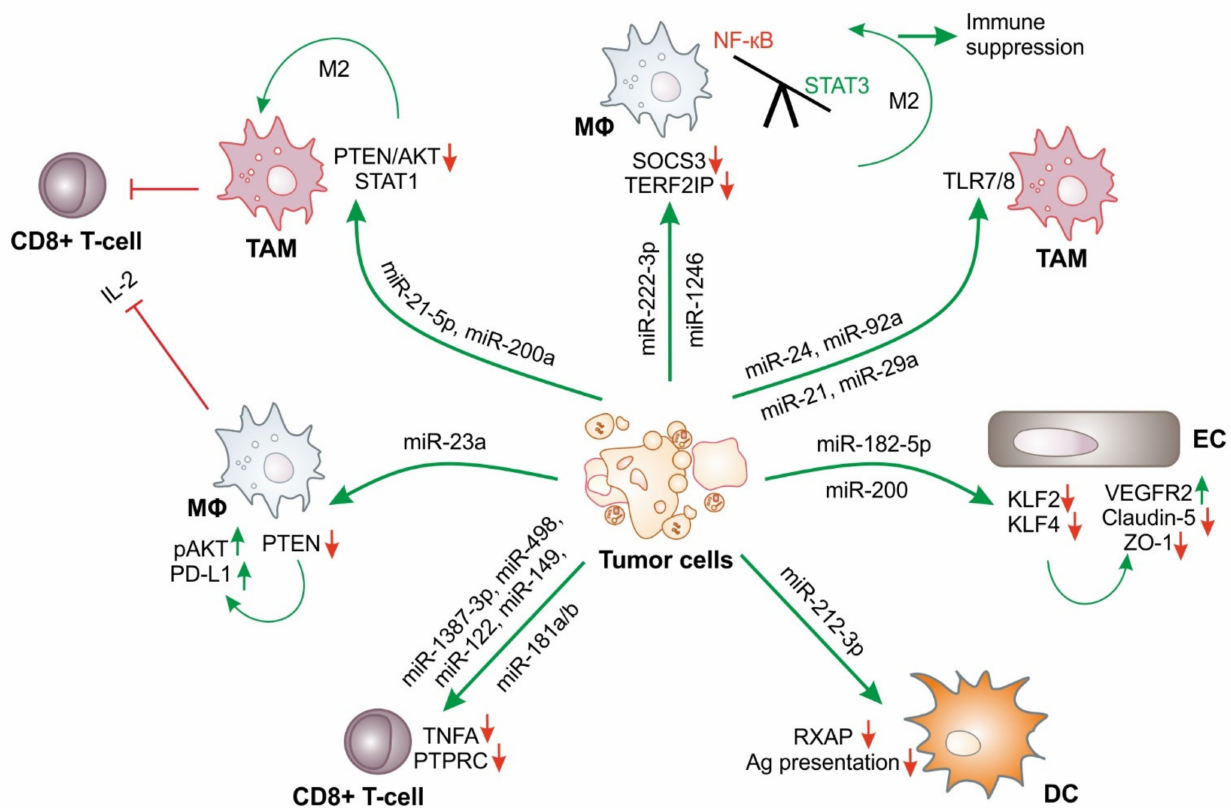
Figure 2. Tumor exosome-derived miRs in the tumor microenvironment. Exosomal miRs are in- volved in nearly all aspects of tumor immunity in the tumor microenvironment. See Section 2.1 for details. M2, alternative (M2) polarization; Ag, antigen; M φ , macrophage. ↓ = Downregulation and ↑ = upregulation. Green arrows are pro-tumoral and red arrows are